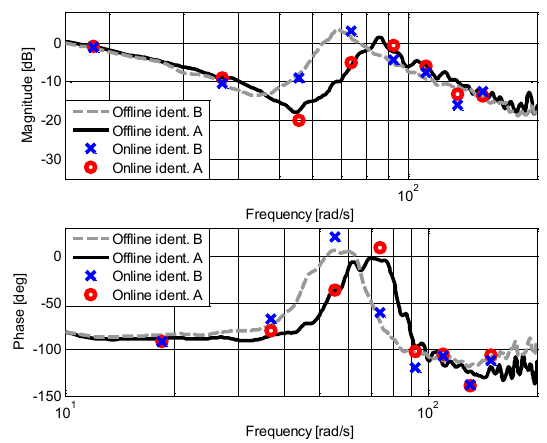
Figure 8: Online-identified frequency response points when the system is changed. The black solid line represents offline-identified system A and the dashed line system B.